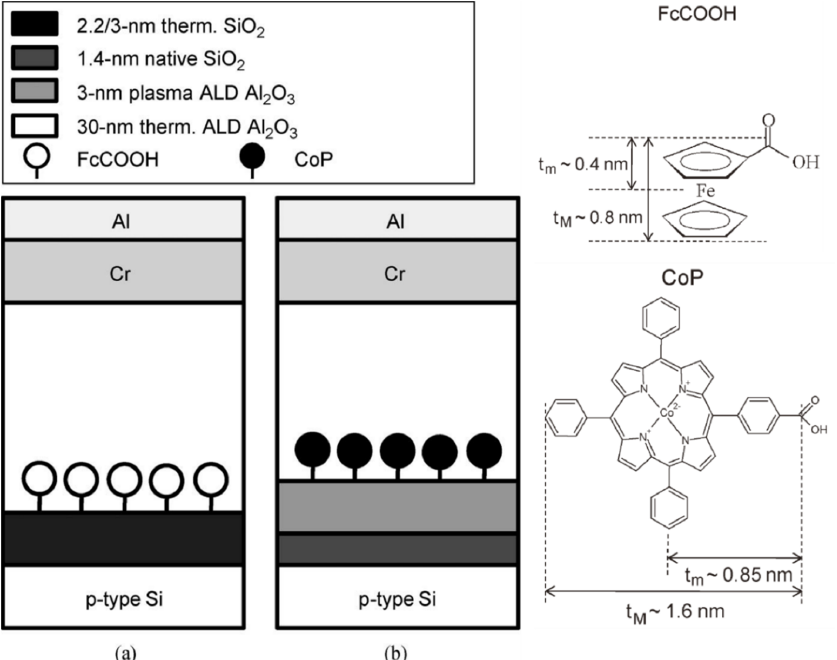
Figure 6. Schematics of the metal-oxide-semiconductor (MOS) capacitor structure with ( a ) ferrocenecarboxylic acid (FcCOOH) and ( b ) CoP SAM attached to Si structures. Reproduced with permission from [42], © IEEE, 2011.